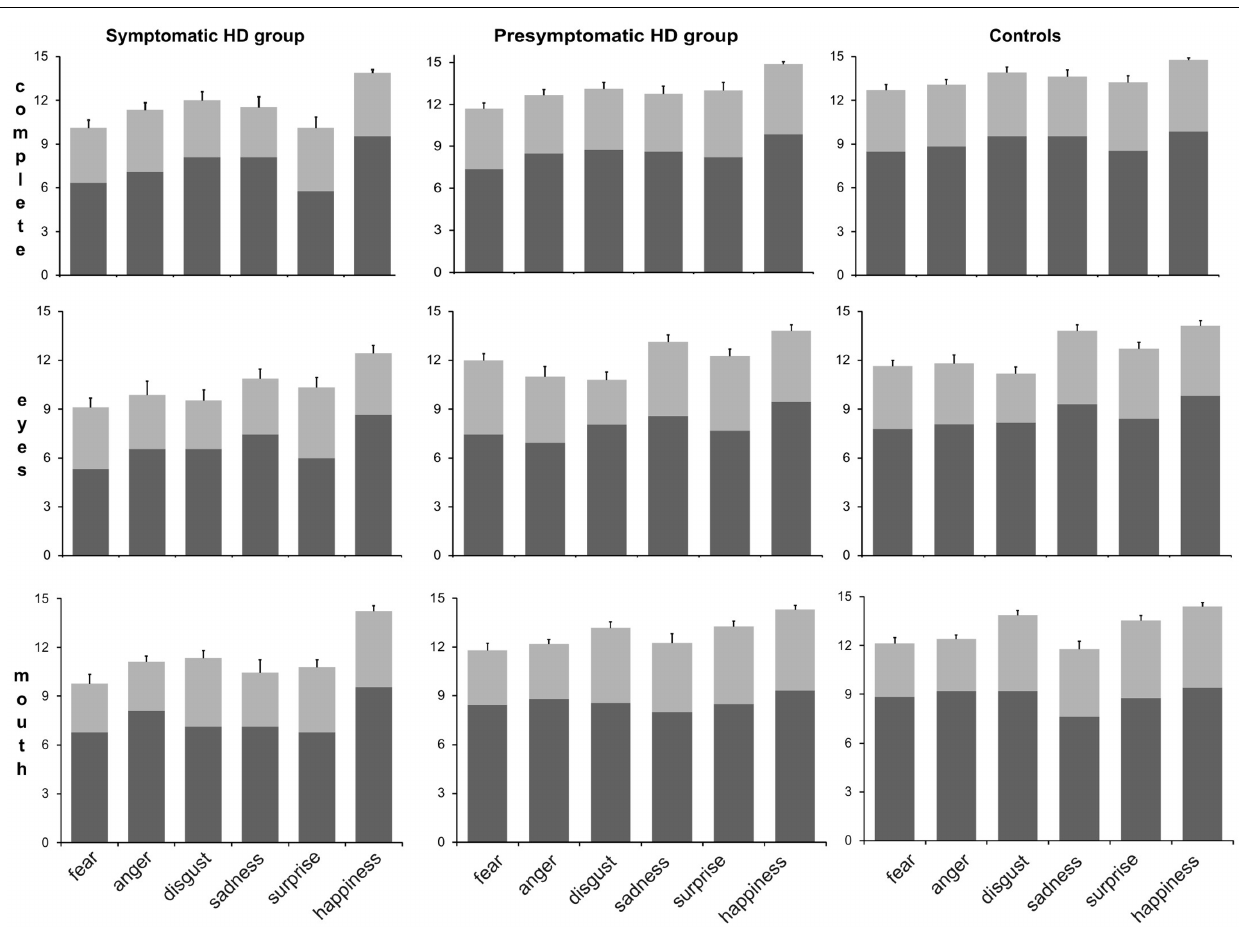
tasks conditions, and the six Emotions. Light gray indicates the correctly identified targets and dark gray indicates the correctly identified